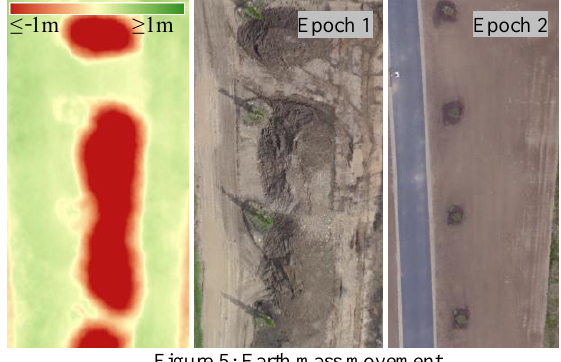
Figure 5: Earth mass movement